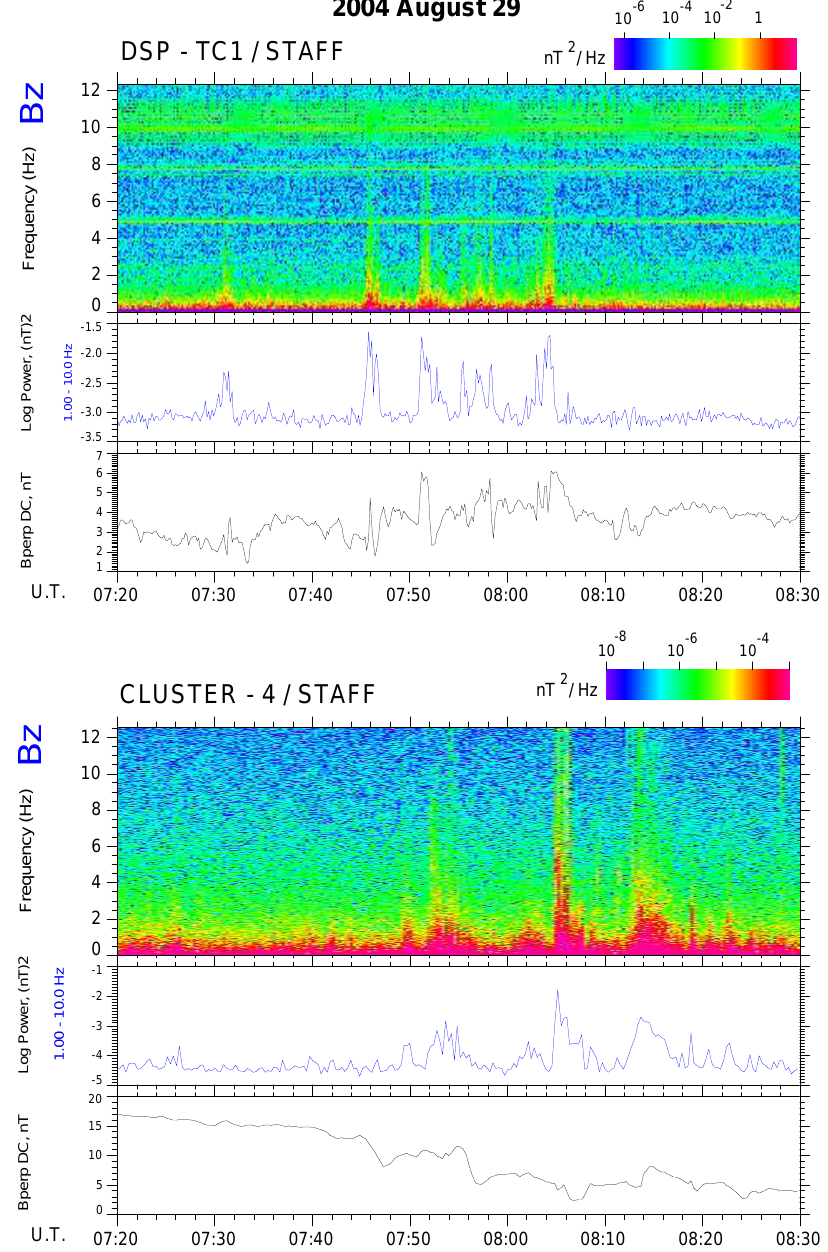
Fig. 13. Simultaneous wave observations by Cluster and DSP in the tail for 29 August 2004. For both spacecraft are given the B z dynamic spectra, integrated power and B perp (see Fig. 12). DSP was in the plasma sheet whereas Cluster enters it, coming from the lobes, at about 07:45 UT. This is a quiet day, with no substorm